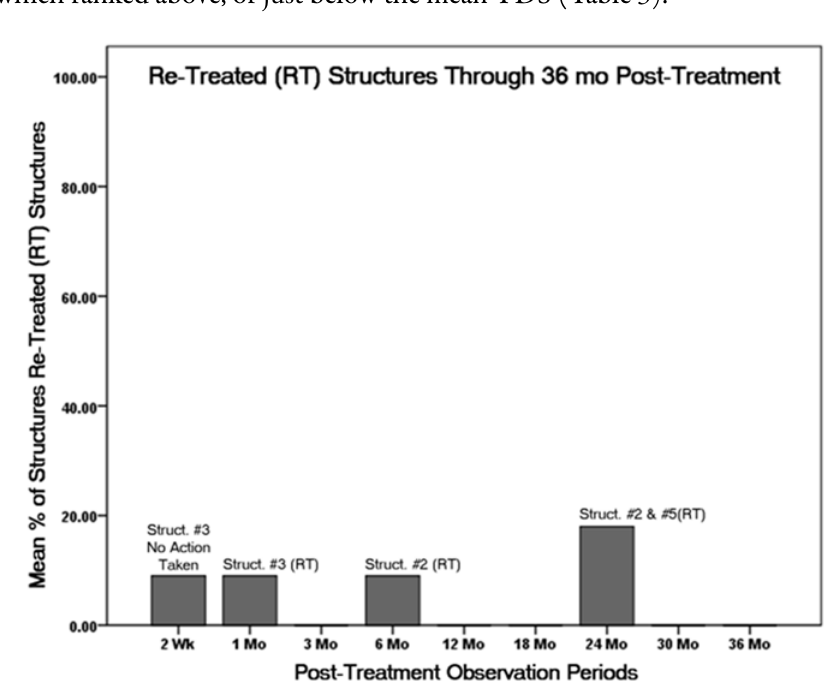
Fig. 5. Mean % of re-treated (RT) structures infested with FST after a post-construction treatment with chlorantraniliprole through 36 mo post-treatment. Nomenclature above bar: Individual structure number and RT (re-treatment). NOTE: Active termites were found at Structure #3 at 2 weeks post- treatment, but no corrective action was taken until 1 month